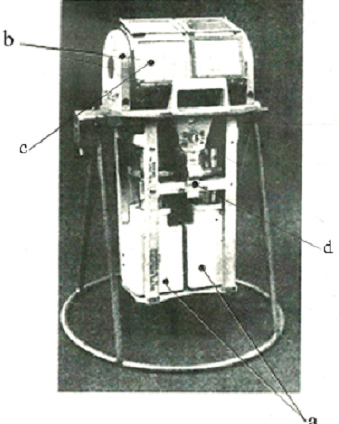
Figure 4. The apparatus “ISPARITEL M”: ( а ) two monoblocks each of which has its electron beam gun for thin metal coating plating; ( b ) six-position drum with two cassettes with samples ( c ) on each face; ( d ) the